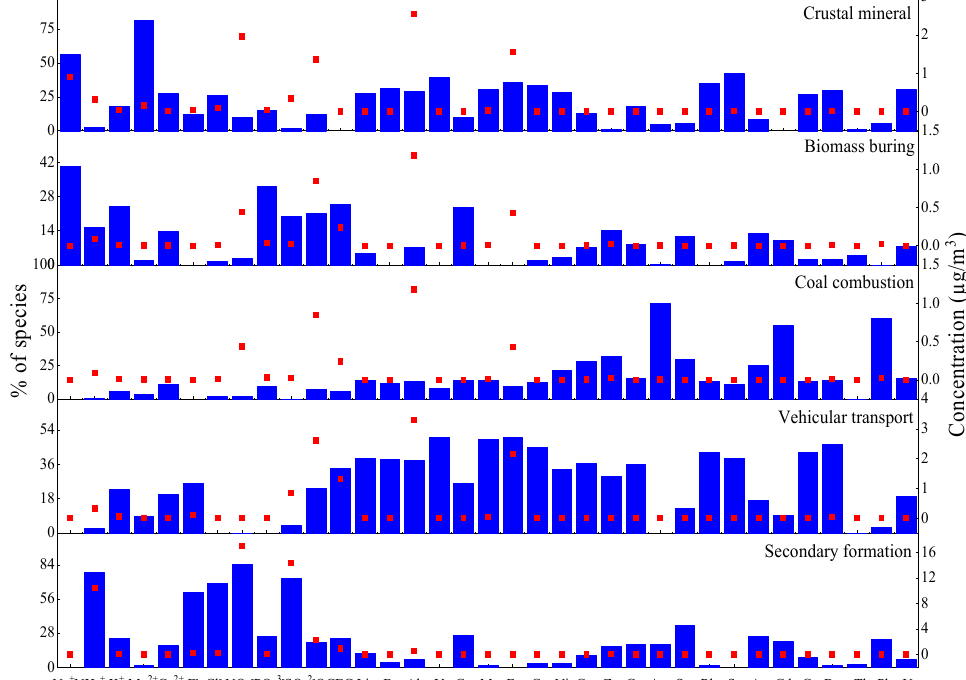
Figure 11. Source profile (%) of chemical components in PM 2.5 in Urumqi.